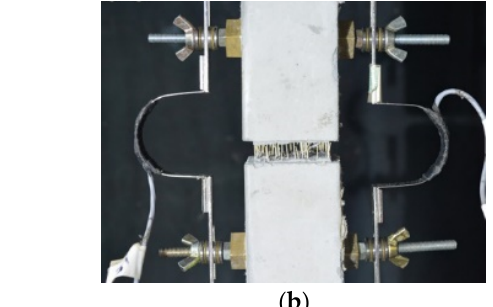
No. 1 No. 2 No. 3 Figure 16. Uniaxial tension test specimen after loading (bottom side). Table 3. Uniaxial tension test results. Specimen  , f  : fiber effectiveness [15]). Figure 17. Comparison of bridging law. The calculation results of the bridging law are also shown in Table 3 and Figure 17. The calculation is carried out using the bilinear model for pullout load–crack width relation described in Section 4.1, considering the inclined fiber angle and rupture of the fiber. The orientation intensity, k , in the elliptic distribution for the probability density function of the fiber inclination angle is set to 1.5 and 6 for two planes parallel to the axial direction, which is the same as in the previous study [15]. The principal angle, q r , is also set to zero. The tensile load (= P bridge ) is divided by the theoretical fiber number across the crack, which can be calculated by V f A m / A f   f , where  f is the fiber 0